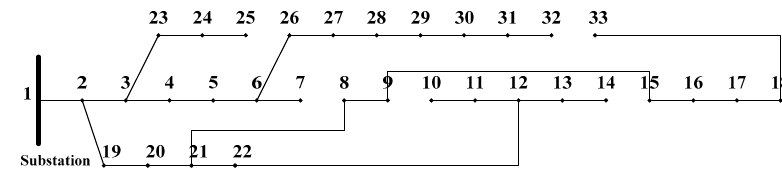
Figure 4. The topology of solution of Scenario IV.